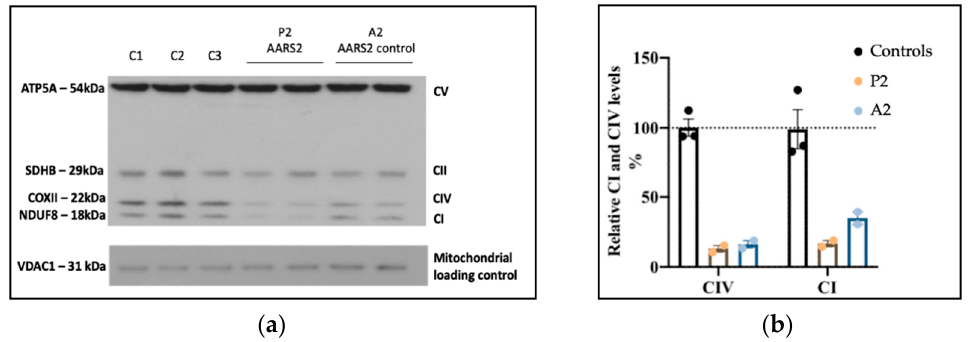
Figure 3. OXPHOS protein expression in patient P2 AARS2 and control fibroblasts. ( a ) Representative Western blot showing decreased protein levels of NDUFB8 (CI) and COXII (CIV) in patient P2 similar to patient A2 (positive control), who harbors likely pathogenic AARS2 variants c.1874G>A (p.Arg625His) and c.665C>T (p.Thr222Ile) in trans [49]; VDAC1 (porin) was used as a mitochondrial loading control. ( b ) Densitometry analysis suggests 85% lower levels of COXII (CIV) in both P2